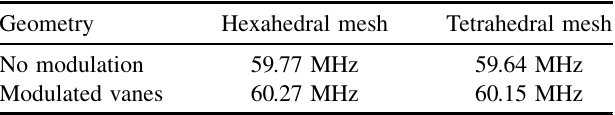
TABLE XII. RFQ frequency calculated with different mesh options before and after including the vane modulation.